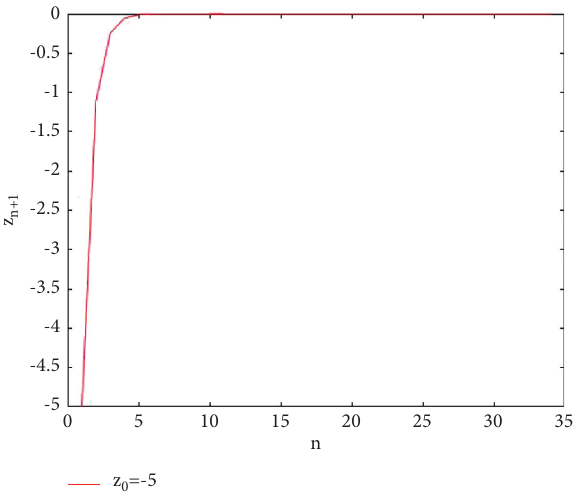
Figure 1: Case I: for the initial value z